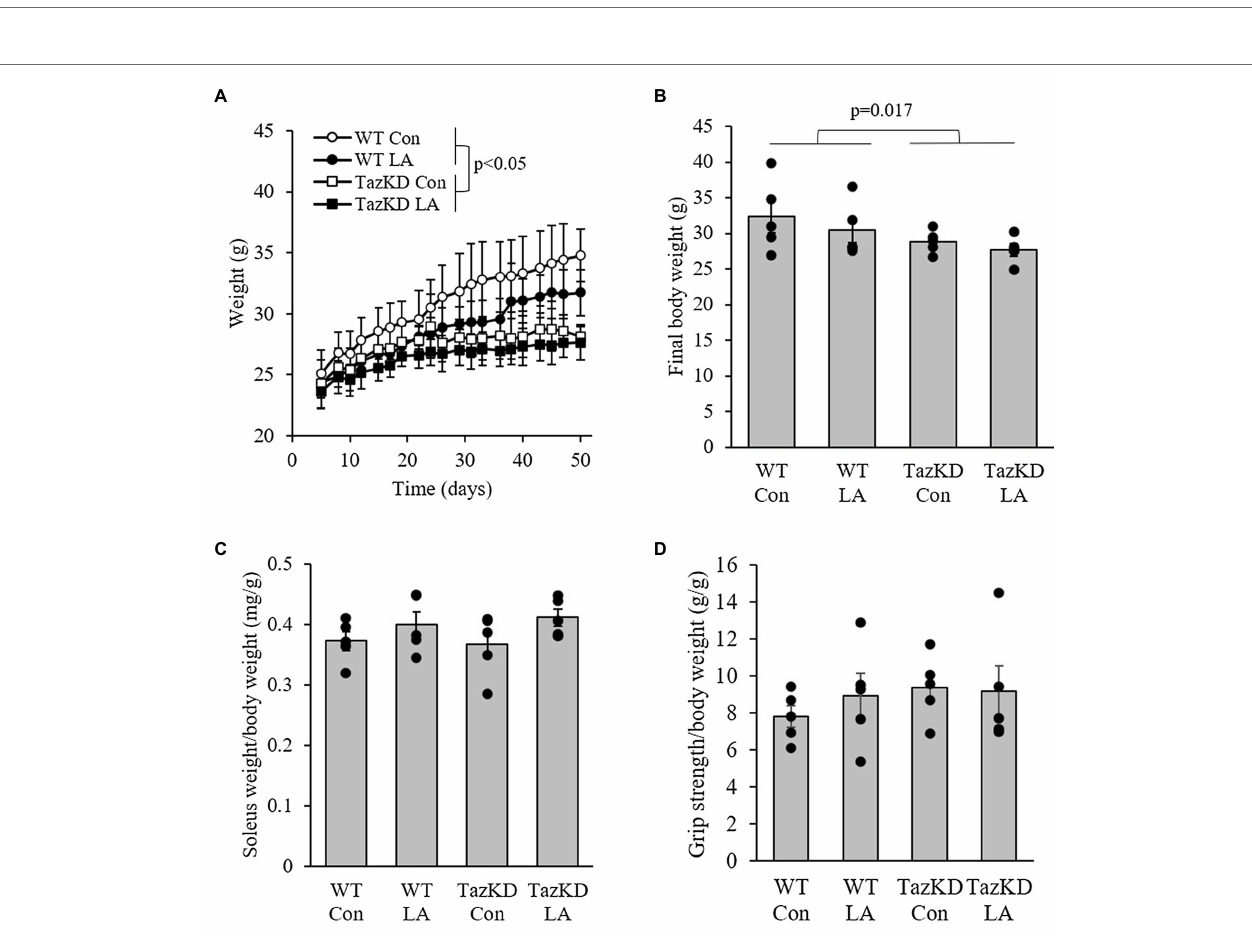
FIGURE 3 | TazKD male mice were (A) slower growing and (B) had lower final body weight compared to their wild-type counterparts regardless of diet over the 8-week intervention. (C) Soleus weight as a fraction of body weight and (D) in vivo grip strength were not different between genotypes and diet. Values are means ± SEM, n = 6. WT, wild type; TazKD, Taz knockdown; Con, chow diet; and LA, linoleic acid-supplemented